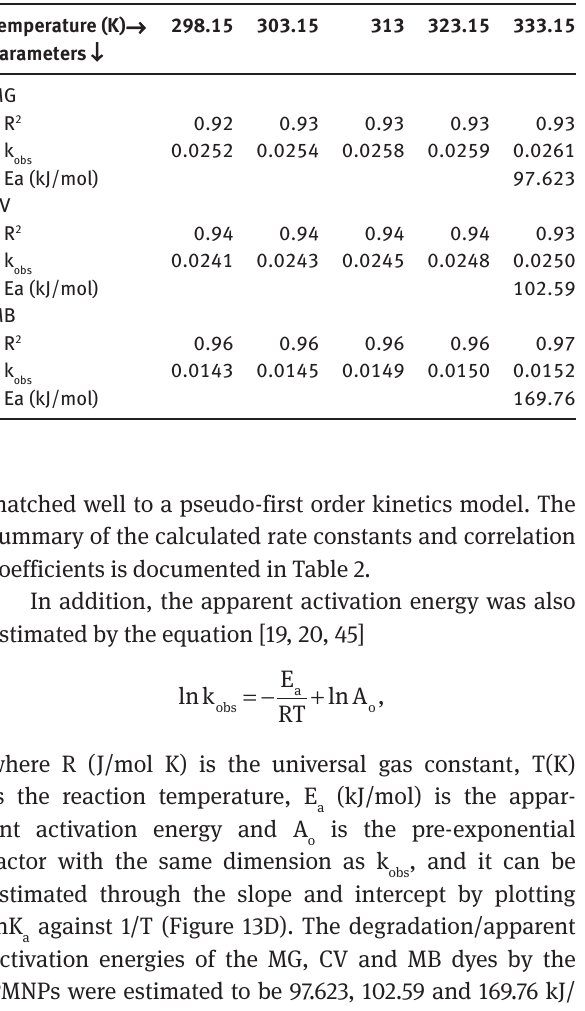
Table 2: The pseudo-first order kinetic parameters for the degrada- tion of malachite green (MG), crystal violet (CV) and methylene blue (MB) dyes by the phytogenic magnetic nanoparticles (PMNPs) at various reaction temperatures.